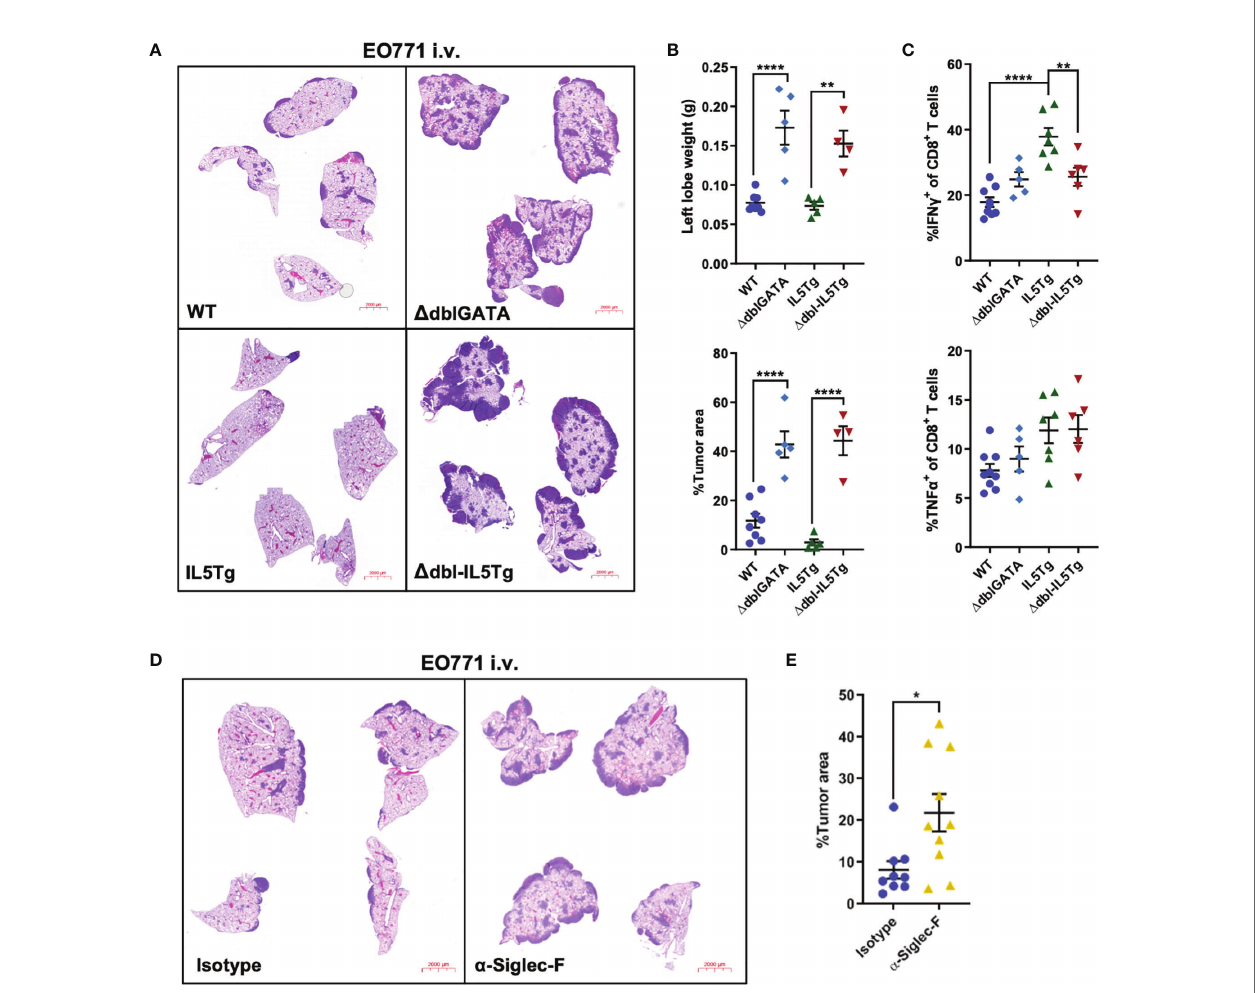
FIGURE 5 | Genetic or immunological eosinophil depletion accelerates pulmonary EO771 tumor growth. (A) Representative images of lungs harvested from WT, IL5Tg, D dblGATA, and D dbl-IL5Tg mice injected i.v. with EO771 cells. Lungs were harvested 14 days post-injection due to accelerated growth in eosinophil-de fi cient D dblGATA and D dbl-IL5Tg mice. (B) WT, IL5Tg, D dblGATA, and D dbl-IL5Tg left lung lobe weights and EO771 tumor area quanti fi cation as a proportion of total lung area of right lung lobes. Data is from one independent experiment, which has been replicated using EO771-GFP cells. (C) Frequency of IFN g + and TNF a + ex vivo stimulated CD8 + lung T cells harvested from WT, IL5Tg, D dblGATA, and D dbl-IL5Tg mice injected i.v. with EO771 cells. (D) Representative images of lungs from WT mice injected i.v. with EO771 cells and treated the next day with 0.6mg/kg a -Siglec-F or IgG 2a isotype control and every 5 days thereafter. Lungs were harvested 13 days post-i.v. EO771 injection. (E) Quanti fi cation of EO771 tumor area as a proportion of total lung area of right lung lobes. Data points are individual mice with mean ± SEM of 4-10 mice per group. *p < 0.05; **p < 0.01; ****p <